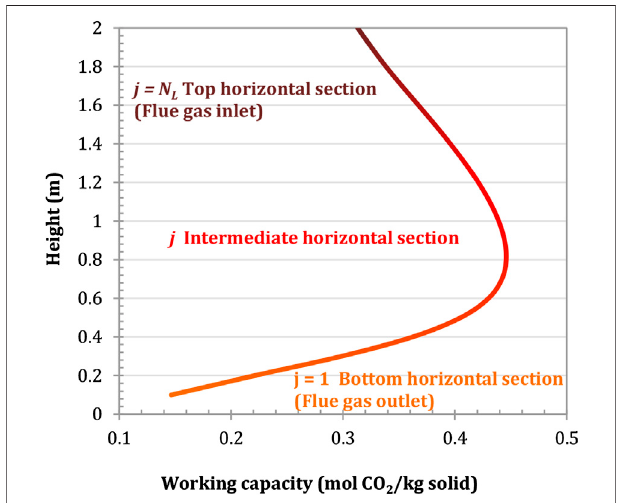
FIGURE 8 | Solid temperature pro fi le for the adsorption (A) and desorption (B) processes at different horizontal sections. Rotation speed of 1 rpm. Con fi guration: parallel S-EGR at 70% recirculation ratio. Adsorbent: Activated